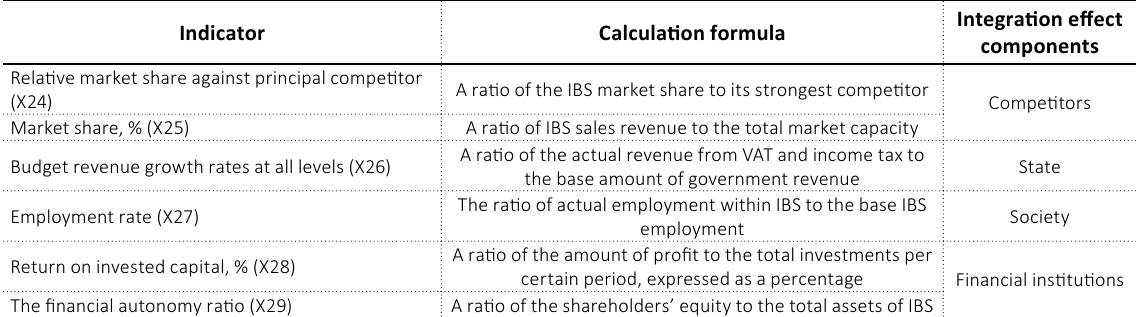
Table A1 (cont.). A set of partial indicators to assess the complementary effect from brand